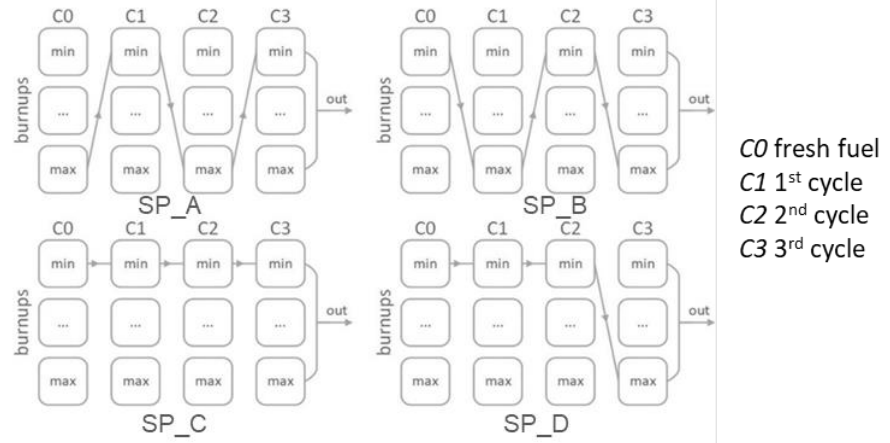
Figure 5. Shu ffl ing procedures developed and tested to determine the discharge burnup of the Figure 5. Shuffling procedures developed and tested to determine the discharge burnup of the individual fuel individual fuel assemblies.